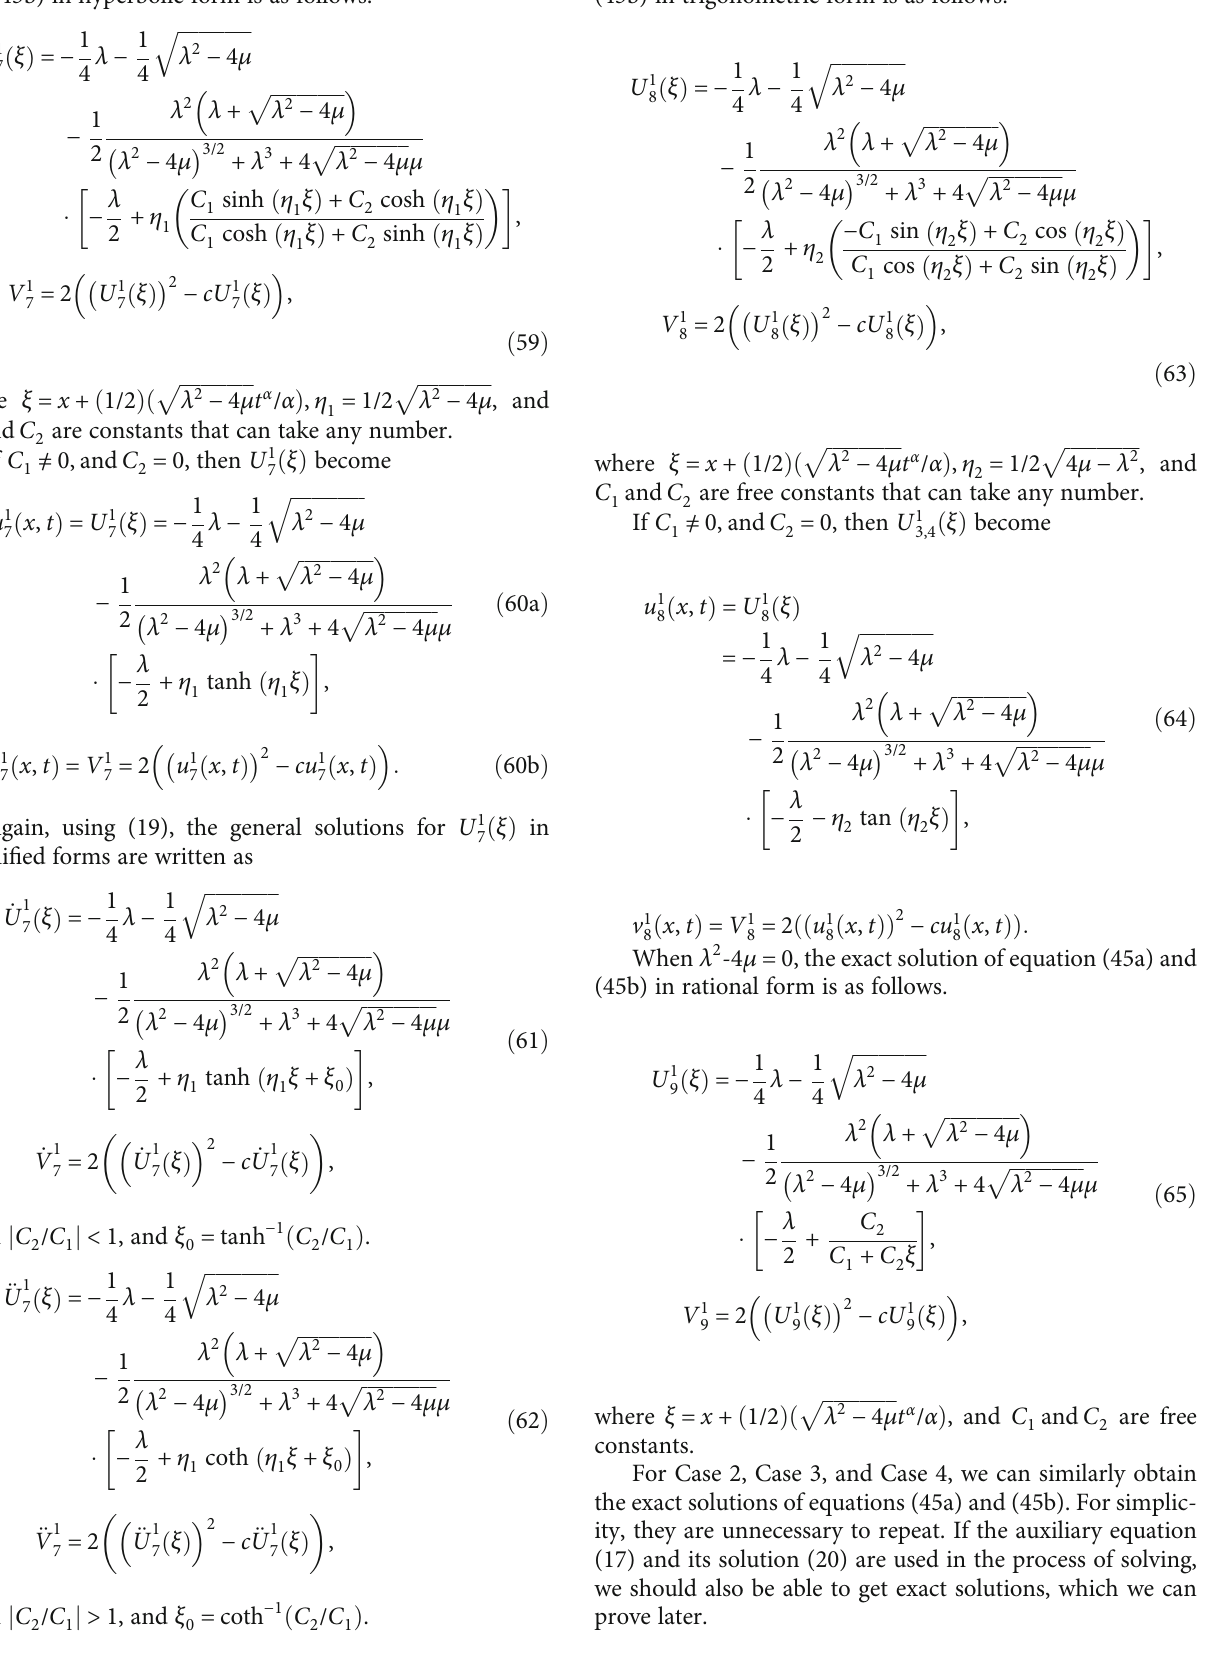
ffiffiffiffiffiffiffiffiffiffiffiffiffiffiffi p λ 2 − 4 μ